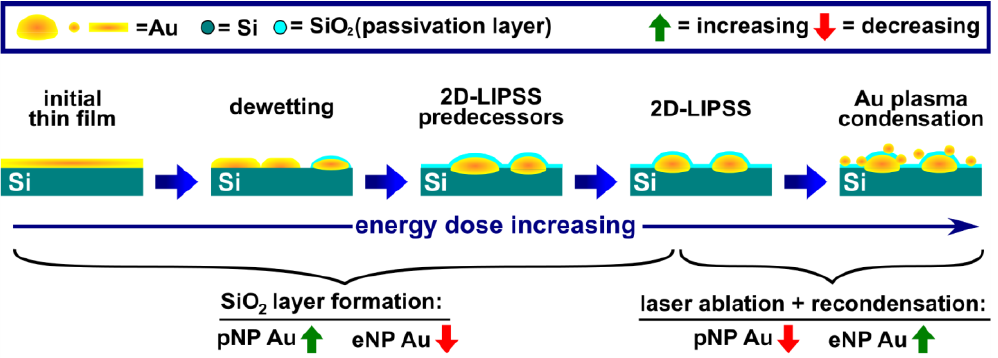
Figure 4. Schematic representation of the most important effects responsible for Au catalyst generation upon nanosecond laser irradiation. Displayed in order of their occurrence upon increased energy dose. Note that several effects may occur at the same time. Au nanoparticles (yellow) covered with a SiO 2 -layer (cyan) are designated to be passivated hence called passivated nanoparticles (pNPs), in contrast to exposed nanoparticles (eNPs) as known from traditional thermal dewetting.